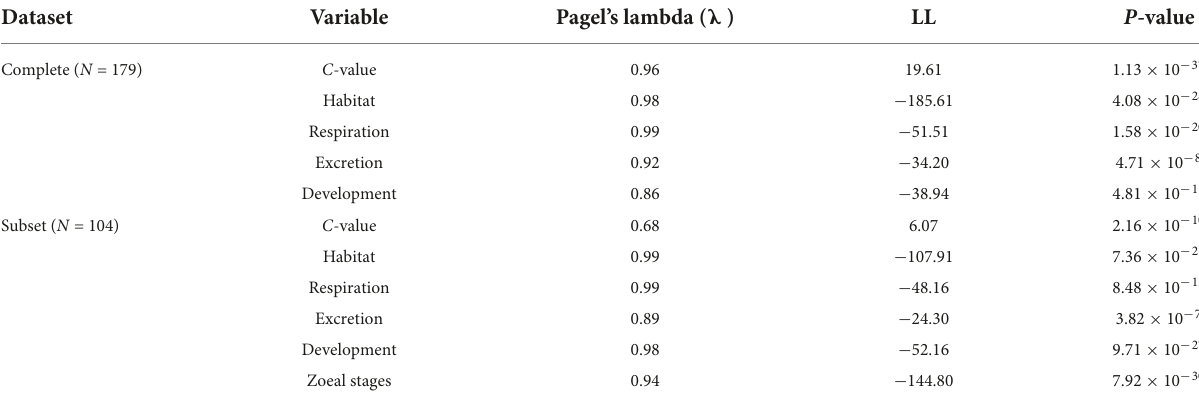
TABLE 1 Values of phylogenetic signal, estimated as Pagel’s lambda ( λ ), for the response and the predictor variables used in the models’ correlation structure both in the complete dataset and in the subset. Dataset